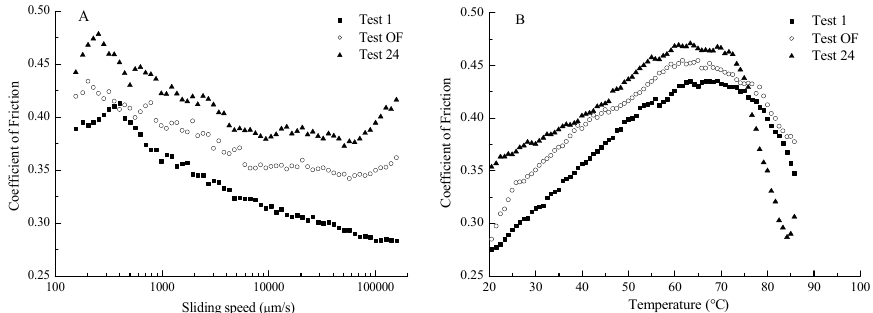
Figure 7. Frictional properties ( A ) Apparent friction, ( B ) Effect of temperature on friction) of the different printing systems (the optimum formulation, Tests 1 and 24 at the viscosity of 1.374, 0.483, and 2.058 Pa·s).